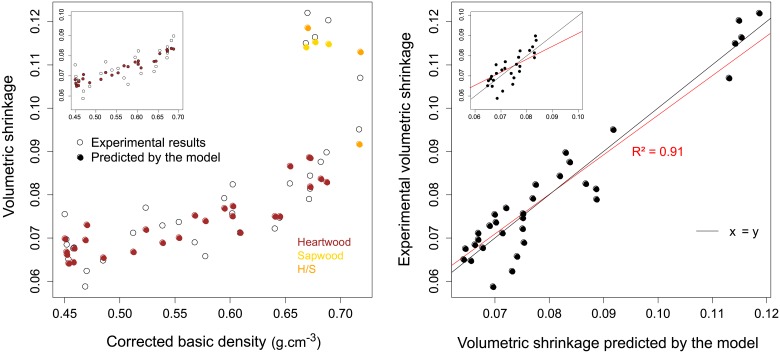
Relationship between total volumetric shrinkage and corrected specific density in sapwood, heartwood and mixed samples.Empty circles and full circles represent experimental results and predictions from the model m3 respectively. On the top-left corner is presented the heartwood-subsampling predictions using model m3_h.